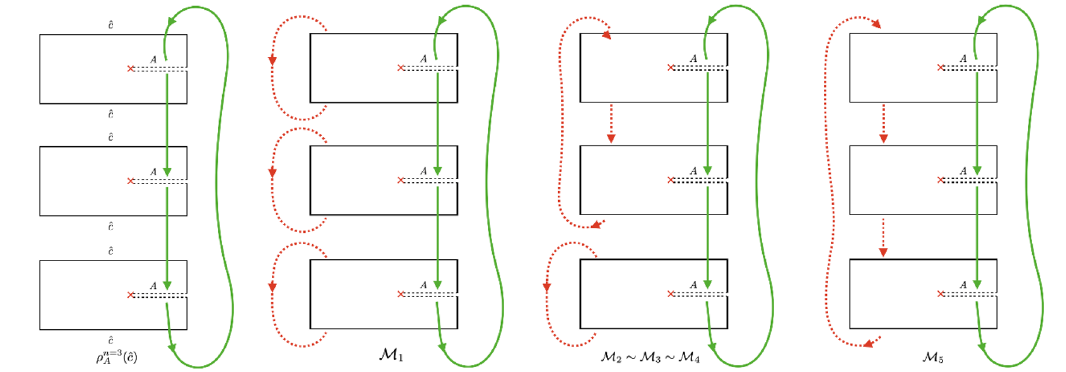
Figure 4 . The four closed manifolds M i ; i = 1 ; : : : ; 5 that emerge after disorder averaging ^ c in (cid:26) n (^ c ) for n = A